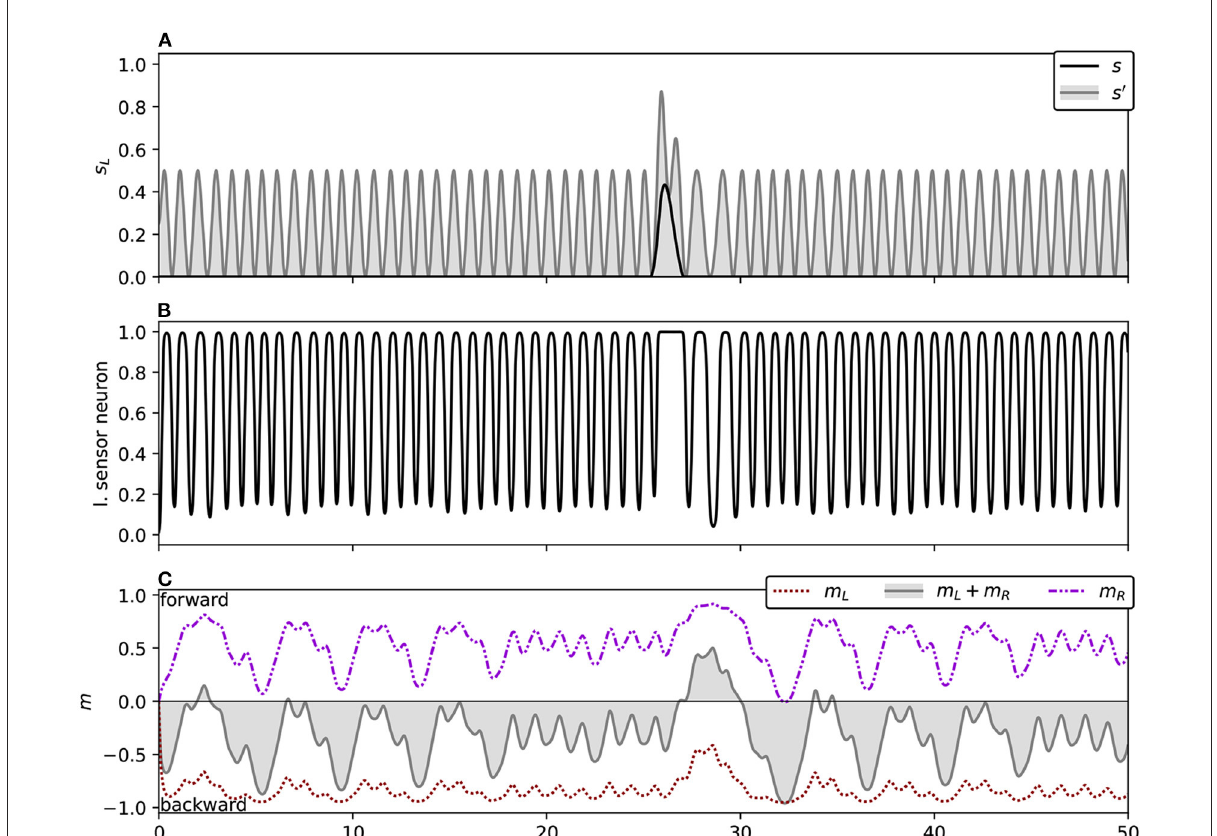
FIGURE13 Sensorimotor activity and sensory neuron output time series are shown for the solution evolved with sinusoidal interference (Equation 14), (A) The left sensor is presented with a spike in environmental stimulation at around t clearly visible—prolonged saturation of the left sensor neuron’s output function (see Equation 5). (C) The spike of environmental sensor stimulation causes the robot to drive forward instead of backwards for a time, demonstrating that the system can respond to environmental stimuli.